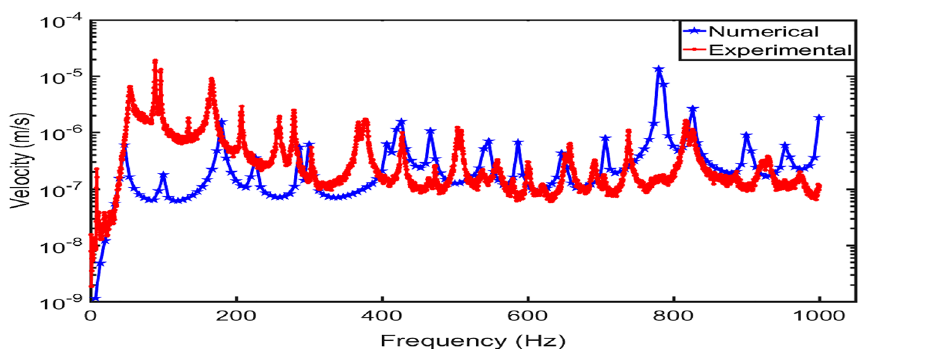
Figure 6. Velocity-frequency response comparison between finite element approximation and experimental measurement with CCCC boundary